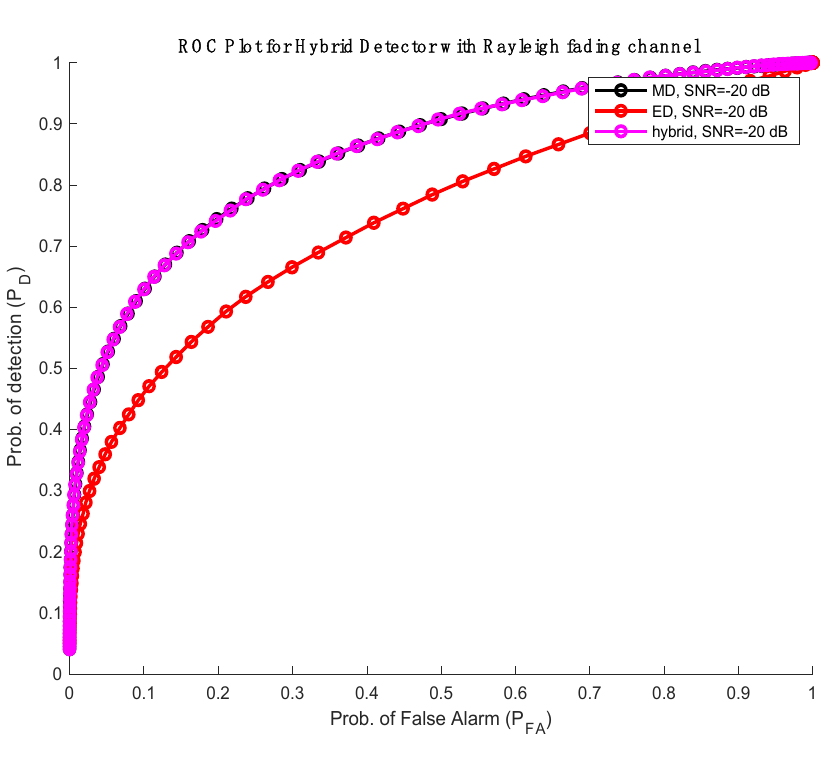
Figure 5. Hybrid detector under non CSS for case 2 .